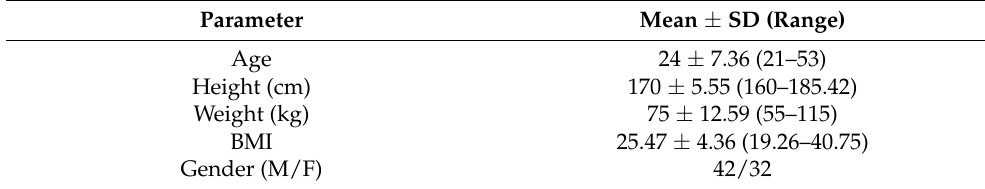
Table 2. The participants’